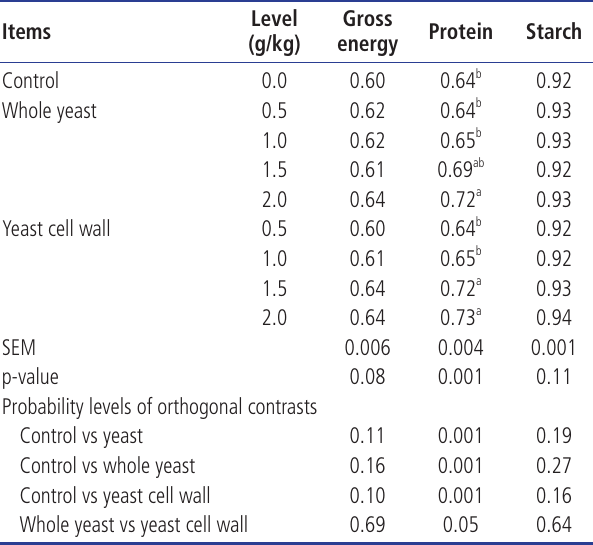
Table 6. Effect of dietary treatments on nutrient ileal apparent digestibility of broiler chickens at 24 d of age